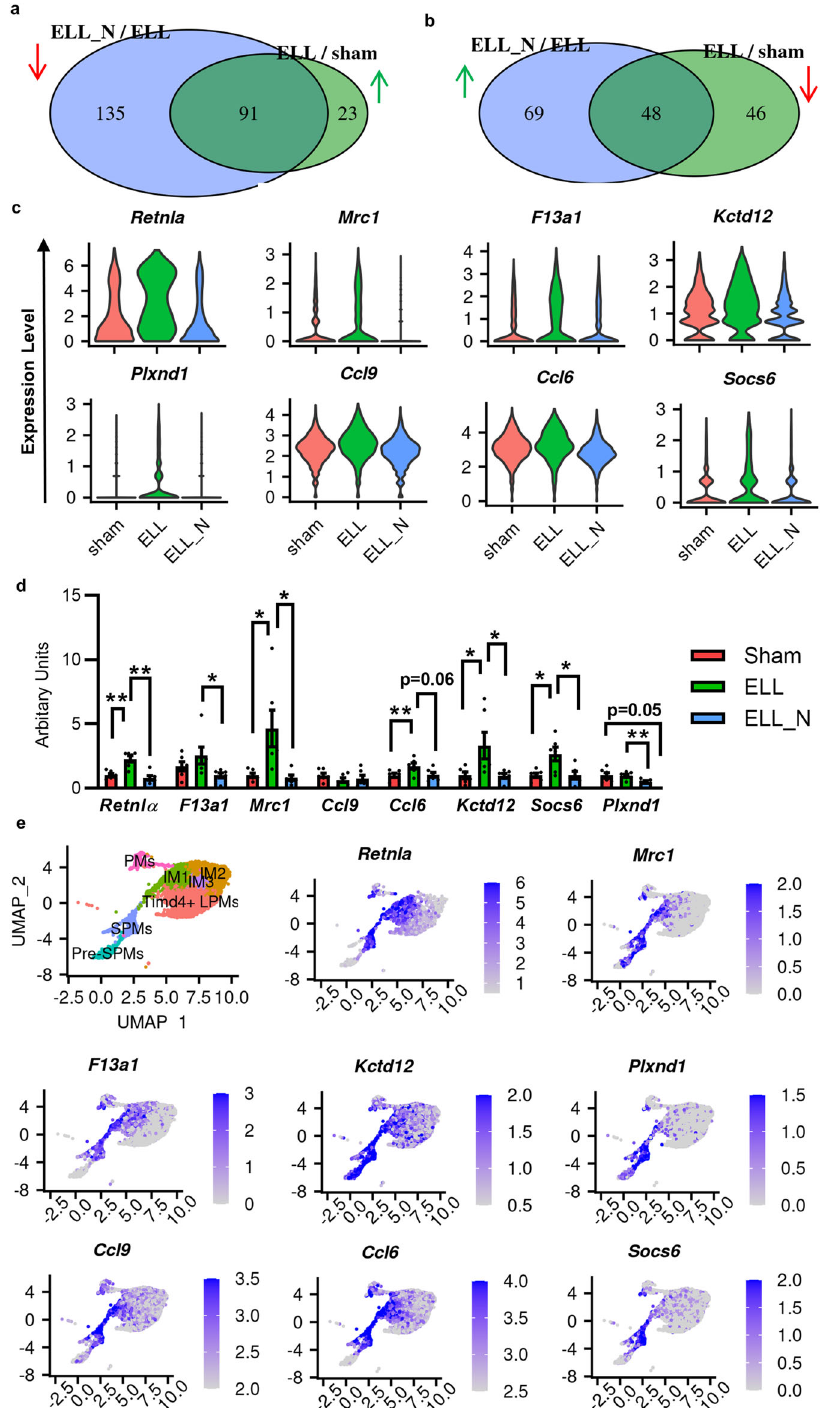
Fig. 3 Genes regulated by ELL and niclosamide and their distributions within the perineal macrophage subpopulations (suppressed by niclosamide). a Venn diagram shows that overlaps of genes that were enhanced by ELL (ELL/sham) but decreased by niclosamide (ELL_N/ELL). b Overlaps of genes that were inhibited by ELL (ELL/sham) but enhanced by niclosamide (ELL_N/ELL). c Vlnplot shows representative genes that were enhanced by ELL but were reduced by niclosamide treatment (ELL_N). All genes shown here were signi fi cantly ( p < 0.05) differentially expressed as determined by the “ wilcox ” test within the Seurat package. d Veri fi cation of differential gene expression by RT-qPCR. * p < 0.05, ** p < 0.01, mean ± SEM, n = 6 per group. e UMAP of computationally selected macrophage populations and the distribution of genes within